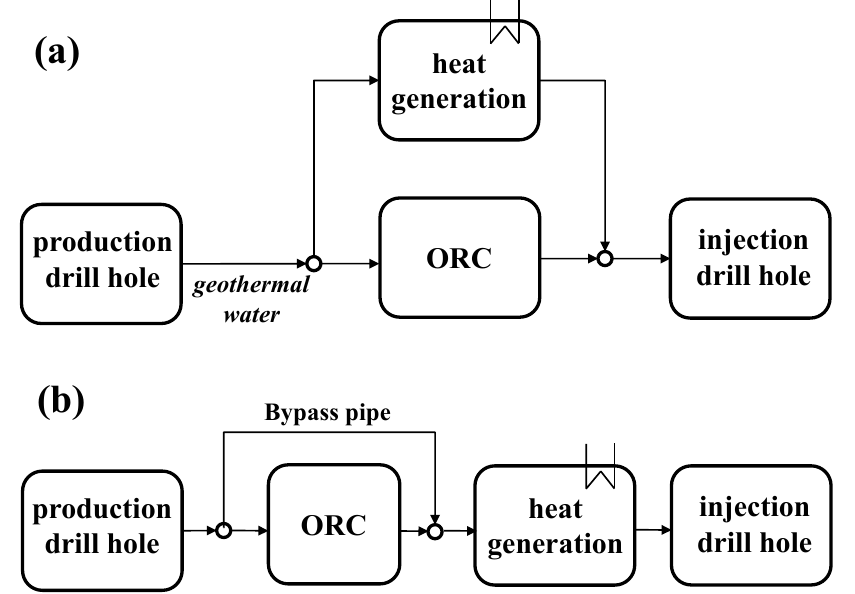
Figure 1. ( a ) Scheme of geothermal CHP in parallel circuit; ( b ) Scheme of geothermal CHP in serial circuit with bypass